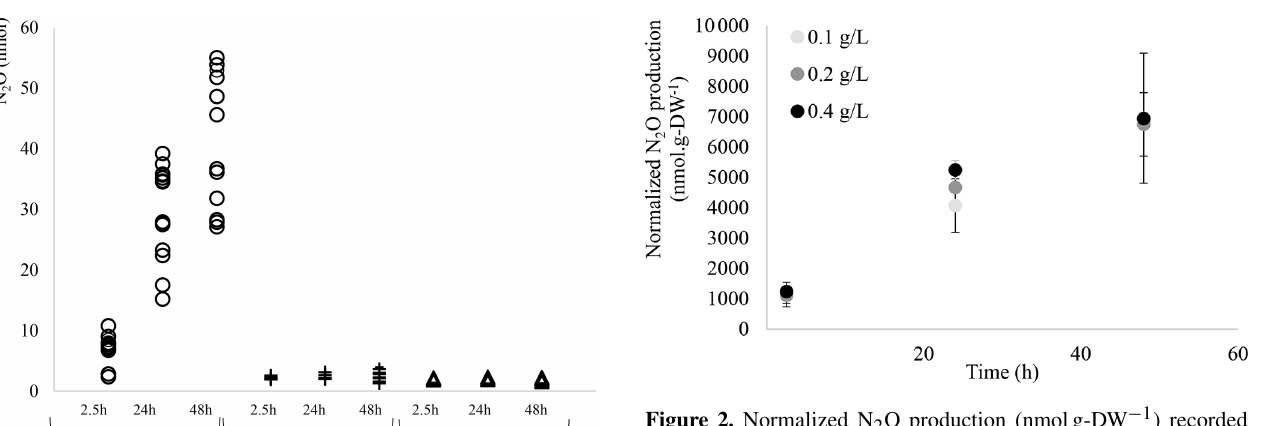
Figure 2. Normalized N 2 O production (nmolg-DW − 1 ) recorded from M. aeruginosa cultures with different biomass concentrations (0.1, 0.2 and 0.4g-DWL − 1 ; n ≥ 6, n ≥ 12, n = 4, respectively) in sealed flasks supplied with light and 10mM NO − Figure 1. Total N 2 O accumulation (nmol) in M. aeruginosa cul- was statistically different when comparing the rates between 2.5 and tures supplied with 10mMNO − under continuous illumination 2 24h and between 24 and 48h ( p< 0 . 05, two-samples t test). Spe- ( ◦ , n ≥ 12), in the abiotic controls (N-free media supplied with cific N 2 O production rates (nmolN 2 Og-DW − 1 h − 1 ) can be found 10mMNO − ; + , n ≥ 10), and in the negative controls ( M. aerug- 2 in Table inosa cultures incubated in N-free media; (cid:52) , n ≥ 10).